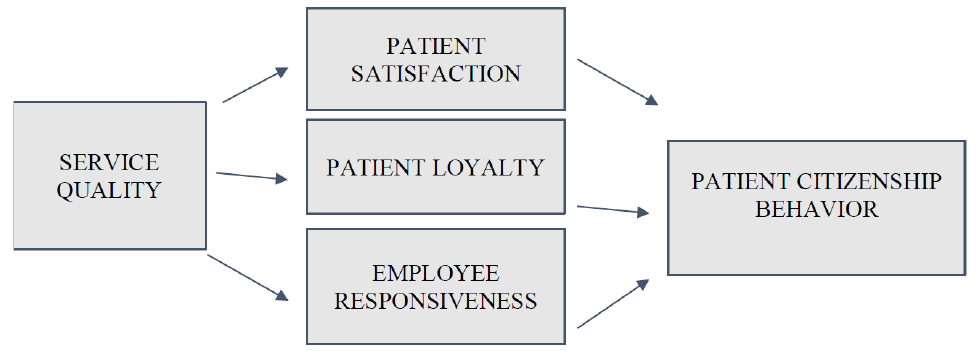
Figure 1. Research